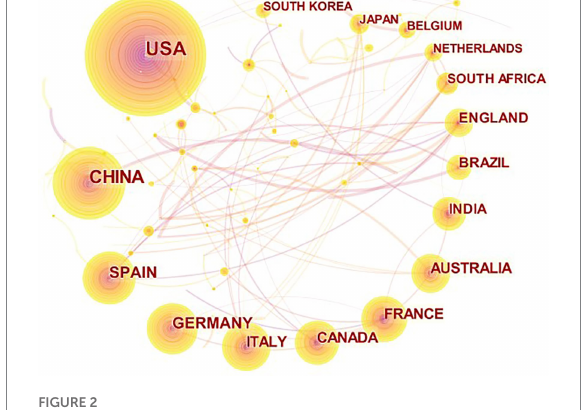
FIGURE 2 Co-current mapping of research institution collaboration on agricultural multispectral research in 2002–2021. The points to circles represent the individual countries, the size of the graph indicates how much literature comes from each country and how influential it is, and the lines represent how close each country is to other